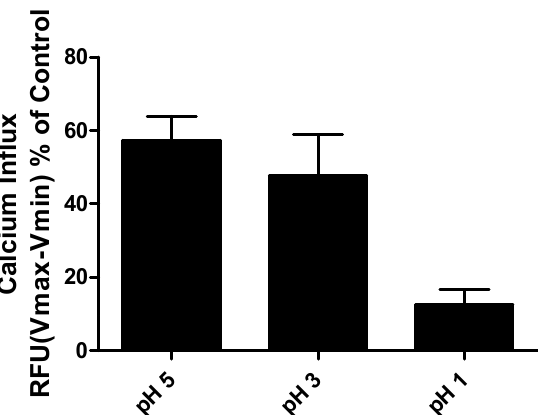
Figure 9. GHSR-1a agonist, CasHyd, displays pH dependent activity. Reduction in hydrolysate-mediated GHSR-1a activation following exposure to acidic pH confirms the need for an oral delivery mechanism. The graph represents three independent experiments carried out in at least triplicate (control = CasHyd not exposed to acidic pH, RFU = relative fluorescence units).